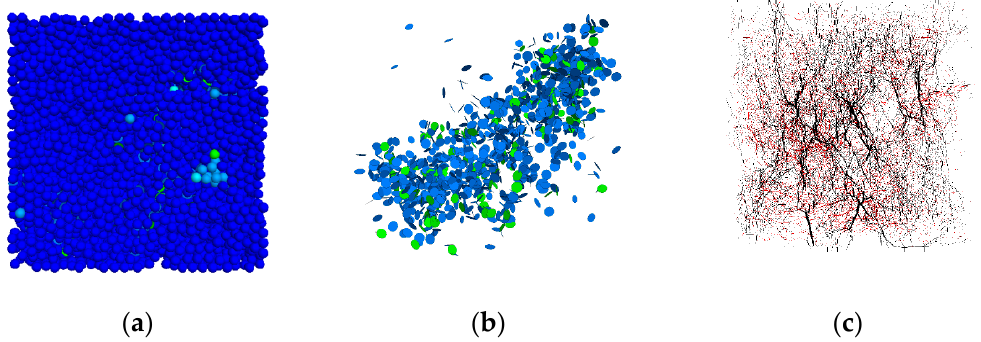
Figure 26. The crack development inside the model of the foamed concrete with a density of 600 kg/m 3 at a loading rate of 0.06 mm/min. ( a ) model failure mode; ( b ) crack development; ( c ) force-chain distribution.